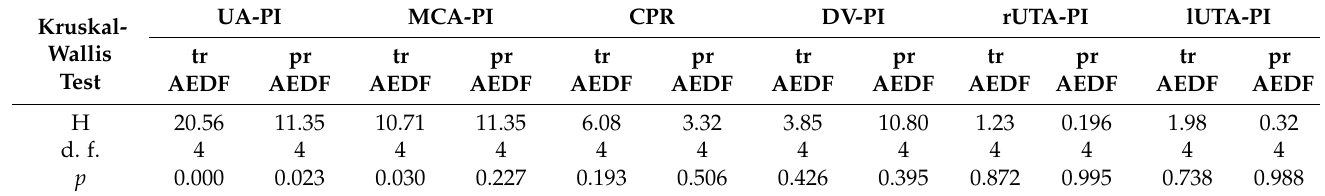
Table 1. Kruskal-Wallis test results on the variation of the pulsatility indexes (PIs) in an umbilical artery (UA), middle cerebral artery (MCA), ductus venosus (DV), and right/left uterine arteries (r/lUTAs), and on the variation of cerebroplacental ratio (CPR), respectively, within the interval between the day 0 (prior) and in the first 4 days after maternal dexamethasone administration, in the two groups: transiently restored and persistent absent end-diastolic flow (tr/prAEDF) in UA. The test was significant ( p < 0.05) for UA-PI in both groups and for MCA-PI in the trAEDF group. The test was nonsignificant ( p > 0.05) for MCA-PI in the prAEDF group and for CPR, DV-PI, and r/lUTAs-PIs in both groups. (H = Statistic test value; d. f. = degree of freedom; p = value for the statistic test).